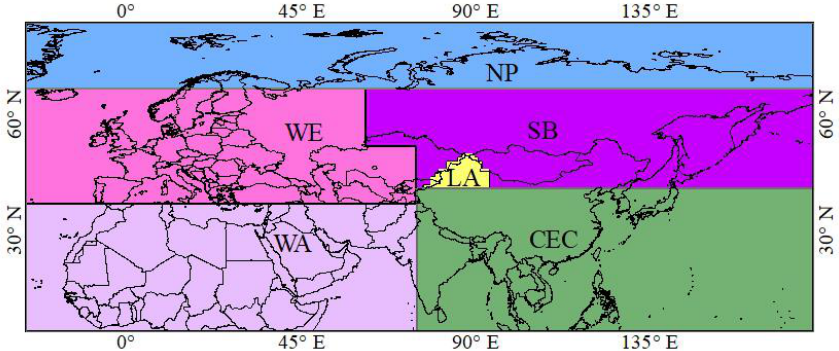
Figure 2. Division of the six water vapor source regions affecting Northern Xinjiang precipitation. These water vapor source regions are named WE (fuchsia pink), NP (vogo blue), SB (amethyst), LA (autunite yellow), WA (lepidolite lilac), CEC (green).